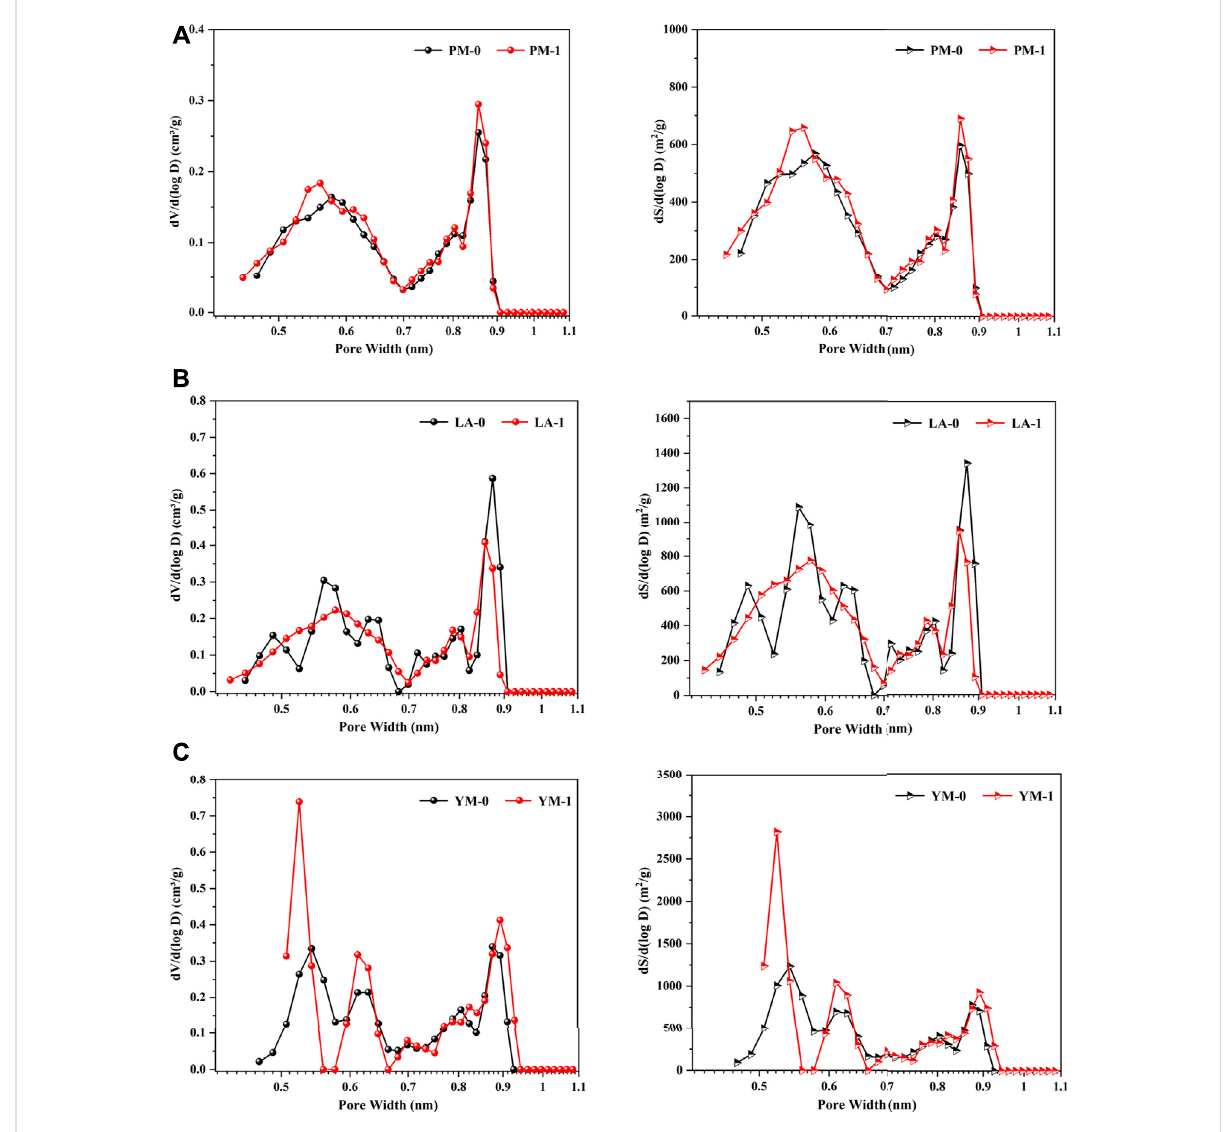
Frontiers in Earth